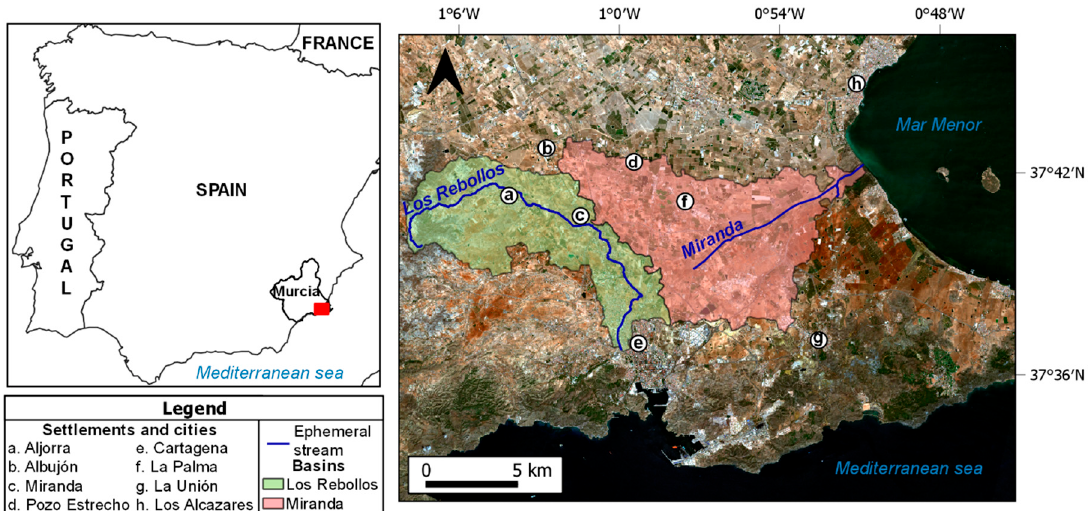
Figure 1. Location of the studied watersheds with the main cities and settlements (Murcia, Spain).